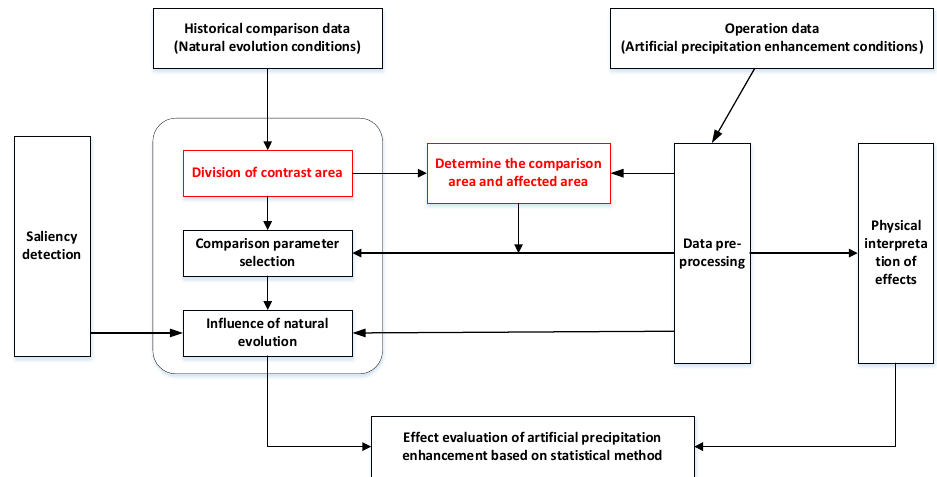
Figure 1. The classical evaluation method of artificial precipitation enhancement effect.